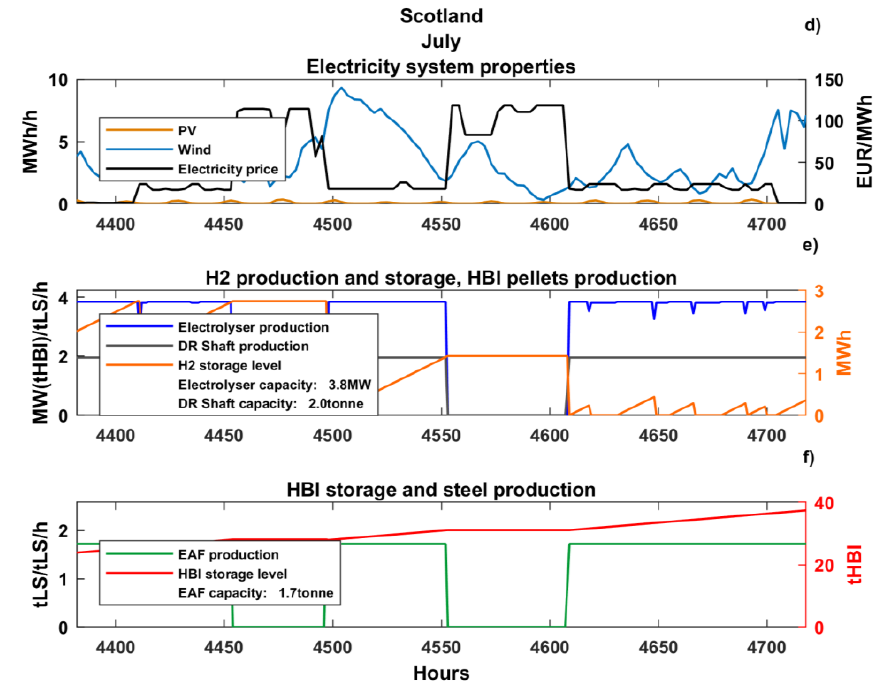
Figure 7. Levels of generation of PV and wind power (MWh/h) and electricity price profiles (EUR/MWh) ( a , d ); production levels of the electrolyser and DR shaft furnace (MW (tHBI)/tLS/h), and state of charge of the hydrogen storage (MWh) ( b , e ); levels of production of the EAF (tLS/tLS/h) and state of charge of the HBI storage (tHBI) ( c , f ), in Scotland for 2 weeks in March (upper plots) and in July (lower plots) in the year 2050.